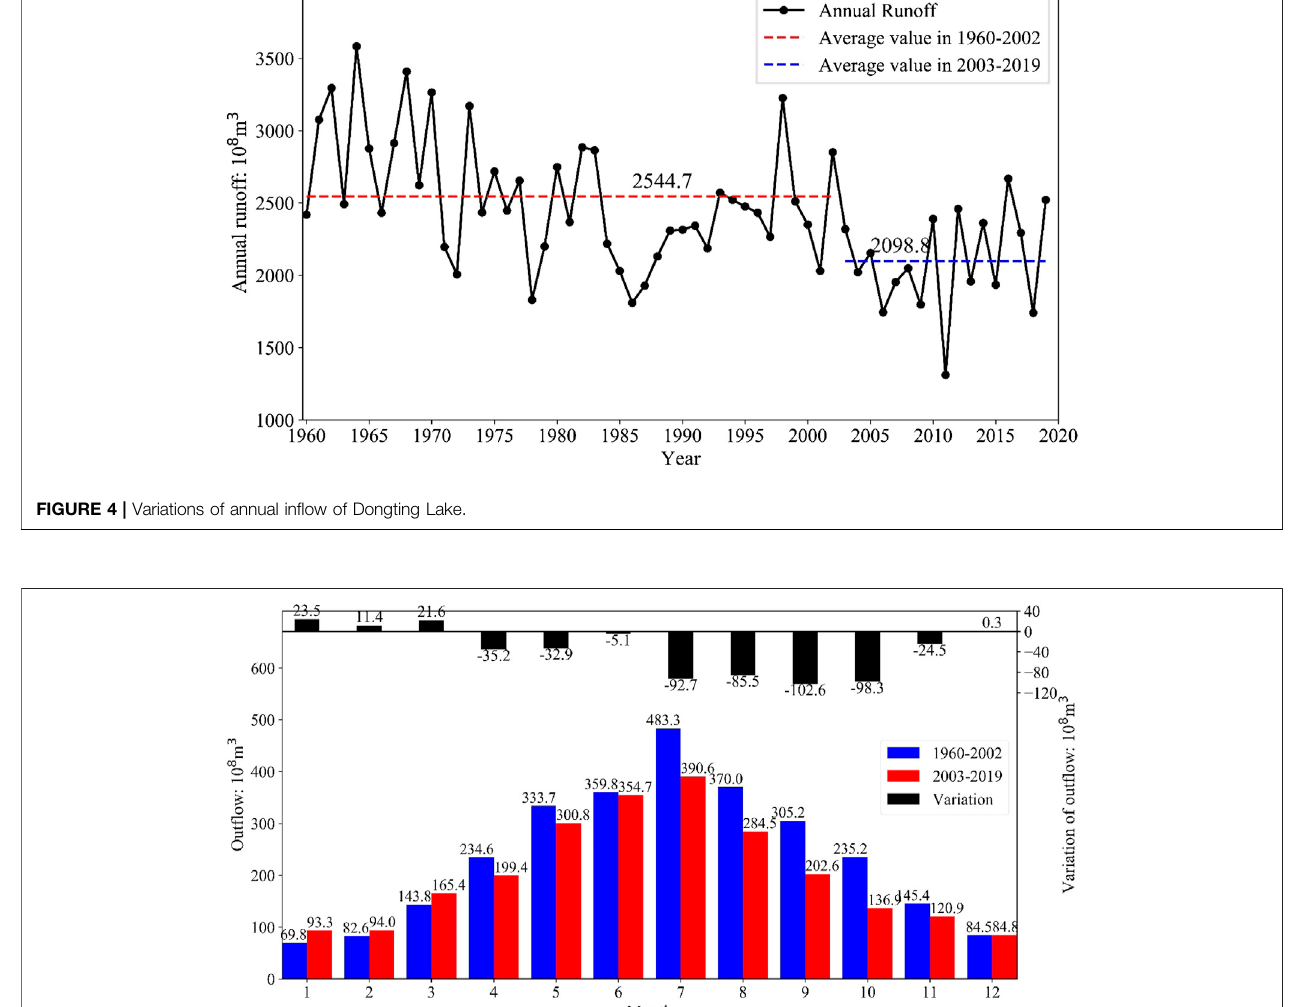
Figure 3A and Table 4 . The average annual in fl ow runoffs to